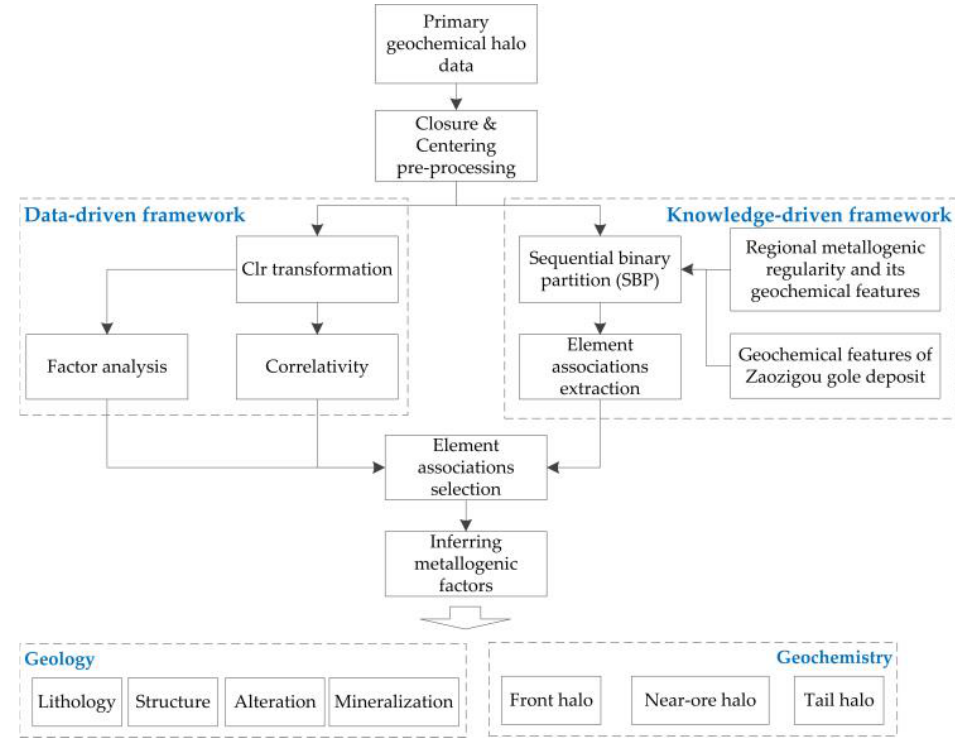
Figure 4. Geochemical CoDA framework.